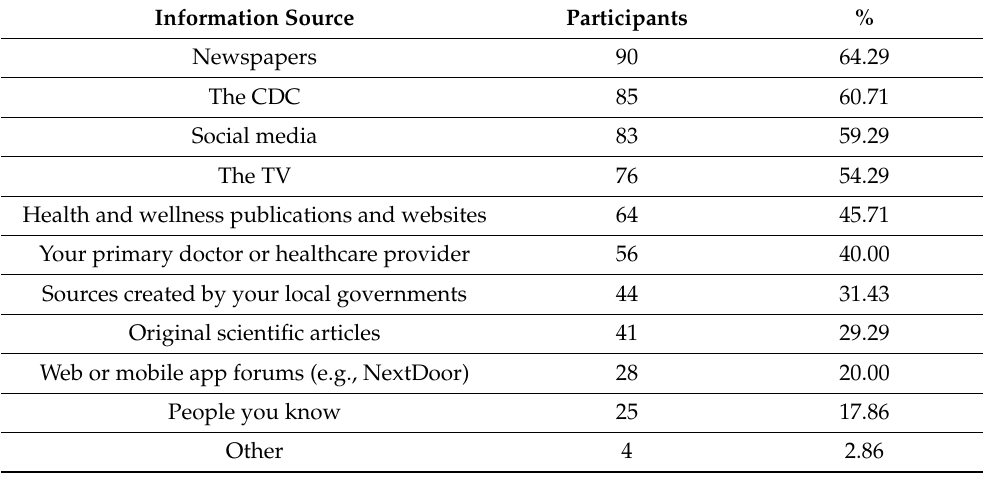
Table 11. Information sources.